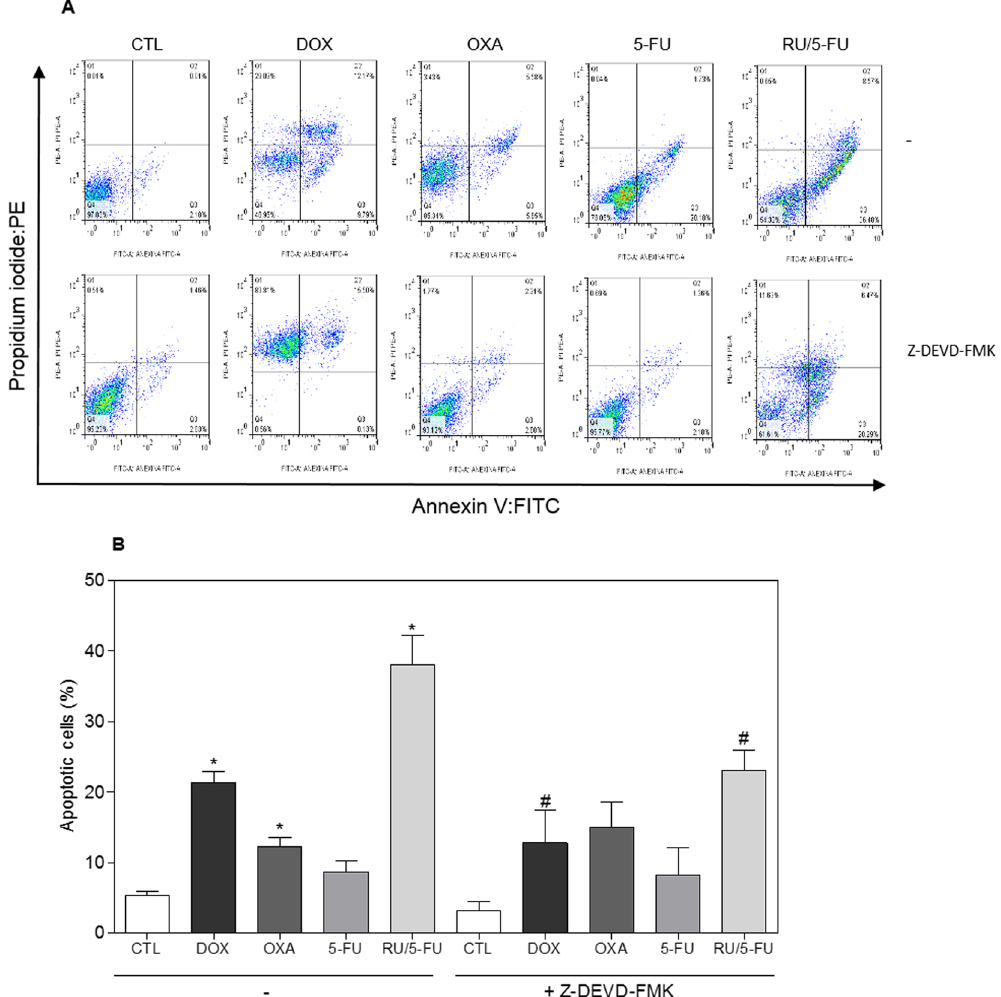
Figure 7. Effect of the caspase-3 inhibitor (Z-DEVD-FMK) in the apoptosis induced by the complex [Ru(5-FU) (PPh 3 ) 2 (bipy)]PF 6 (RU/5-FU) on HCT116 cells determined by flow cytometry using annexin V-FITC/PI staining. ( A ) Representative flow cytometric dot plots showing the percentage of cells in viable, early apoptotic, late apoptotic and necrotic stages. ( B ) Quantification of apoptotic cells. The cells were pre-treated for 2 h with 50 µ M Z-DEVD-FMK, then incubated with 4 μ M RU/5-FU for 48 h. The negative control (CTL) was treated with the vehicle (0.1% DMSO) used for diluting the compound tested. Doxorubicin (DOX, 1 µ M), oxaliplatin (OXA, 2.5 µ M) and 5-fluorouracil (5-FU, 4 µ M) were used as the positive controls. Data are presented as the mean ± S.E.M. of three independent experiments performed in duplicate. Ten thousand events were evaluated per experiment and cellular debris was omitted from the analysis. * p < 0.05 compared with the negative control by ANOVA followed by Student Newman-Keuls test. # p < 0.05 compared with the respective treatment without inhibitor by ANOVA followed by Student Newman-Keuls